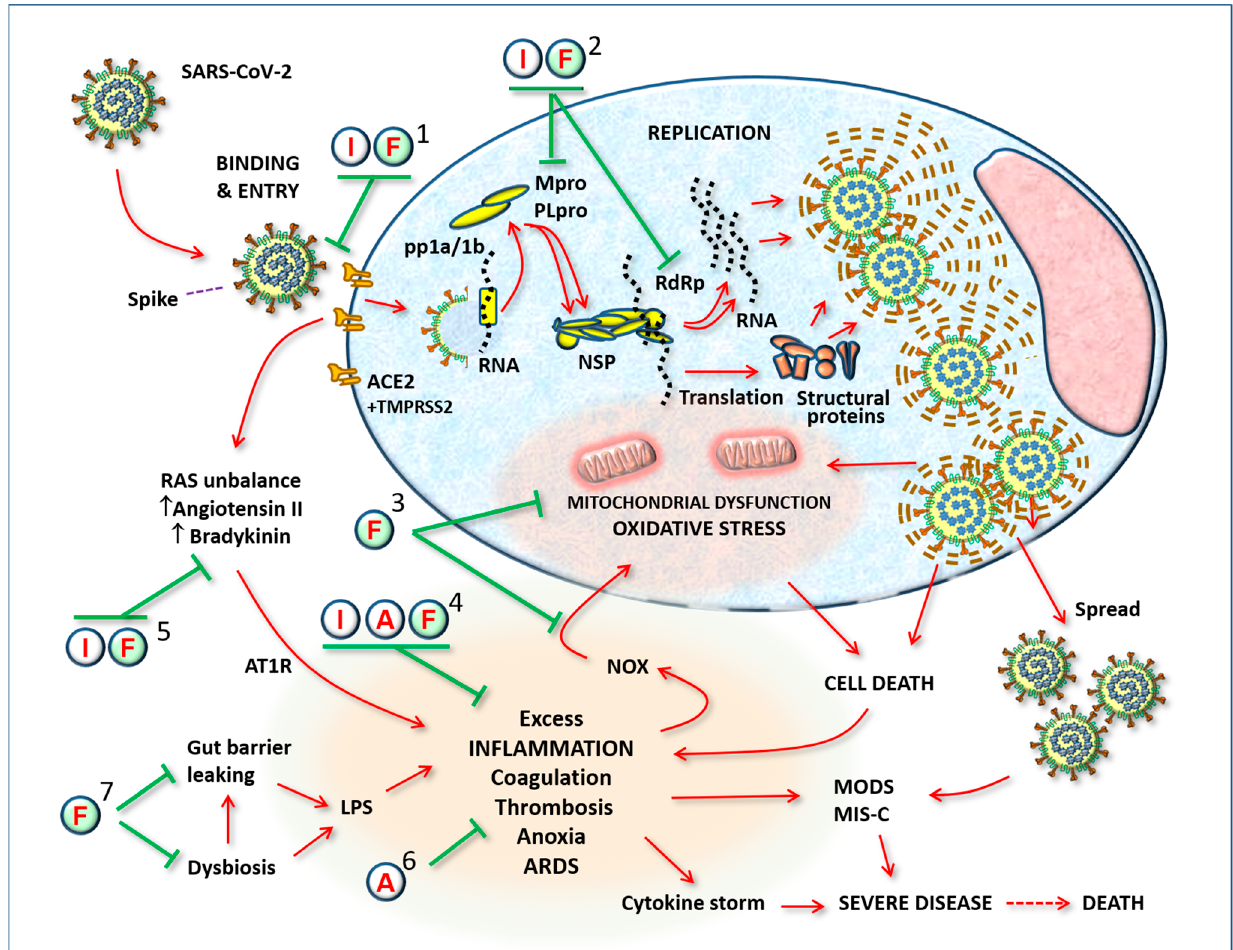
Figure 1. General outline of viral infection and the complications caused by its spread in the body. The substances proposed here for a possible therapeutic effect in coronavirus infection may act in the various stages: (1) preventing binding of the virus to receptors or inhibiting the function of the receptor itself, when it initiates the process of internalization; (2) inhibiting replication by blocking proteases, Non-structural proteins, RNA polymerases, or the assembly of new virus particles; (3) by helping the cell resist viral attack, i.e., by stopping the process of cytotoxicity mediated by oxygen free radicals; (4) by modulating excess inflammatory reactions; (5) by modulating RAS imbalance; (6) by preventing thrombosis; (7) by modulating gut microbiota and preventing systemic release of pro-inflammatory LPS. Abbreviations: SARS-CoV-2: severe acute respiratory syndrome-Coronavirus- 2; I: Indomethacin; F: Flavonoids; A: Low-dose aspirin; ACE2: angiotensin-converting enzyme-2; PRSS2: transmembrane serine protease 2; NSP: non-structural proteins; RdRp: RNA-dependent RNA